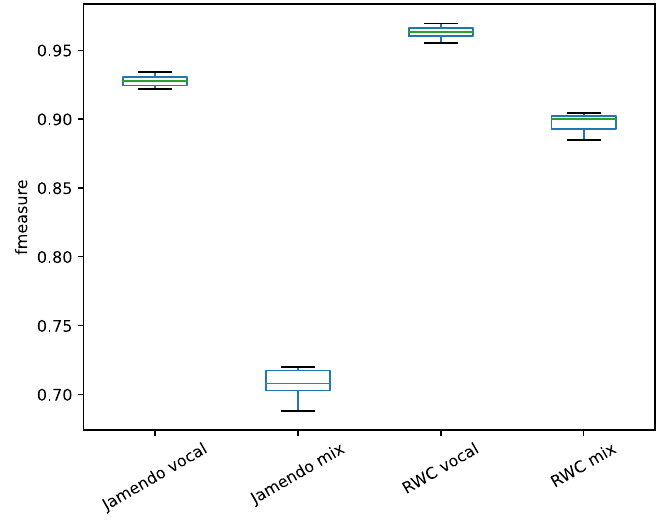
Figure 4. The comparison of different audio data with singing voice separation as